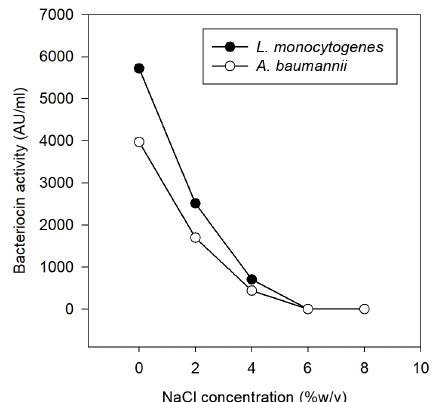
Fig. 11. Effect of salt (NaCl) concentration on partially purified bacteriocin activity